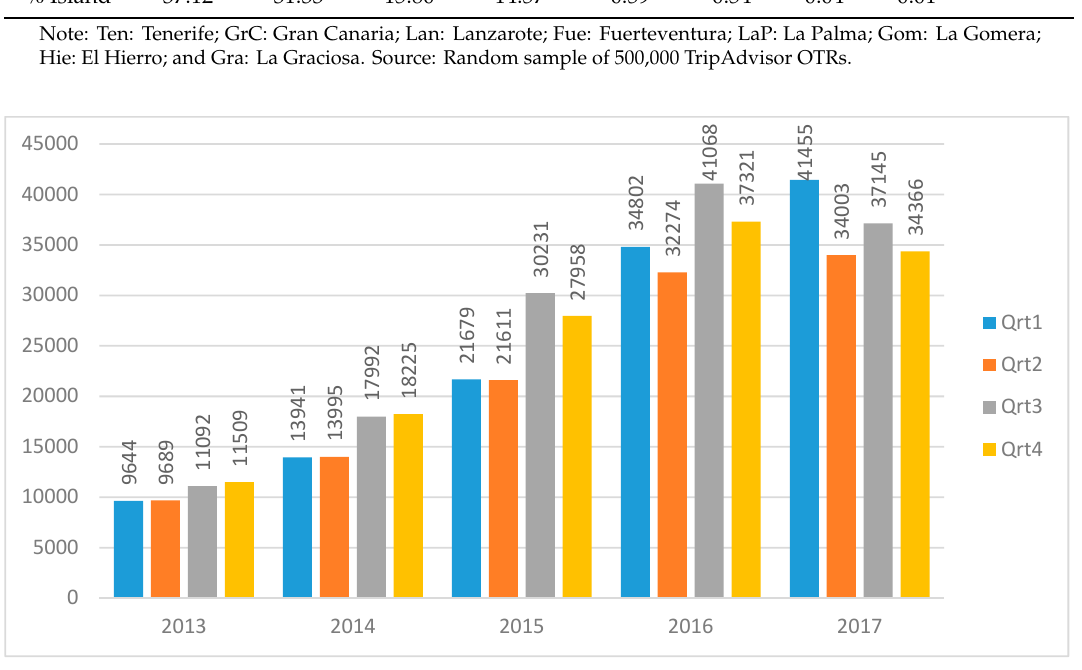
Figure 3. Restaurant reviews by year and quarter. Source: sample of 500,000 TripAdvisor online travel reviews (OTRs).